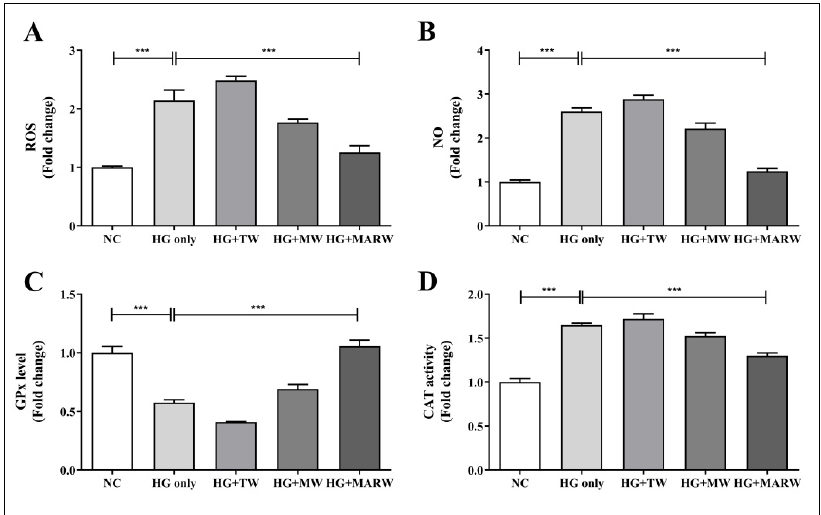
Figure 2. Effects of MARW on ROS, NO, GPx and CAT in HG-induced HK-2 Cells. HK-2 cells were induced with glucose 71.68 mM for 24 h and then treated with TW, MW and MARW, and the ( A ) ROS, ( B ) NO, ( C ) GPx, and ( D ) CAT levels were analyzed. *** p < 0.001 indicates significant differences when tested with Tukey’s ANOVA test. Values represent the mean ± SEM ( n = 3). Abbreviations: NC, normal control; HG, high glucose; TW, tap water; MW, mineral water; MARW, magnesium-enhanced alkaline-reduced water.